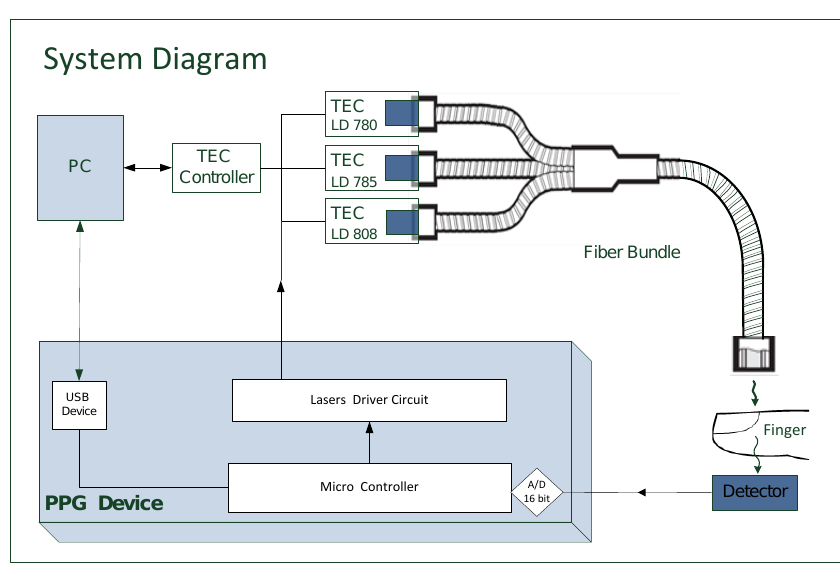
Figure 5. Block diagram of the measurement